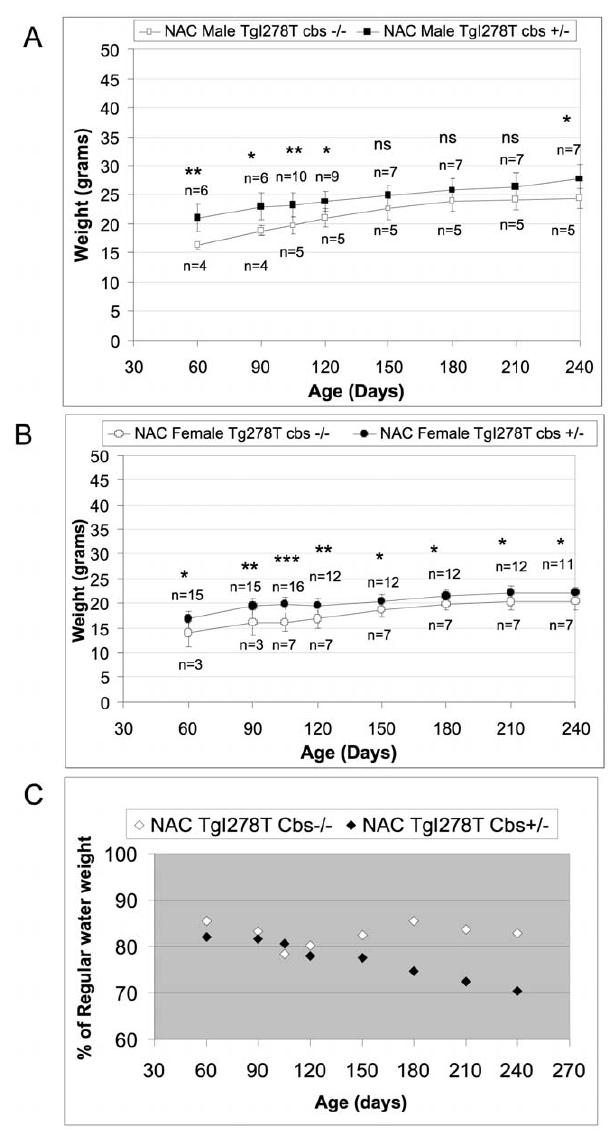
Figure 6. Comparison of weight of NAC treated TgI278TCbs 2 / 2 and TgI278TCbs + / 2 mice over time. ( A ) Weights of male mice. ( B ) Weights of female mice. ( C ) Shows the % of regular water weight for each genotype at each time point. Significance was done by unpaired t test: *p , 0.05; **p , 0.01; ***p , 0.001; ns (non significant). Graphs show the mean 6 SD.